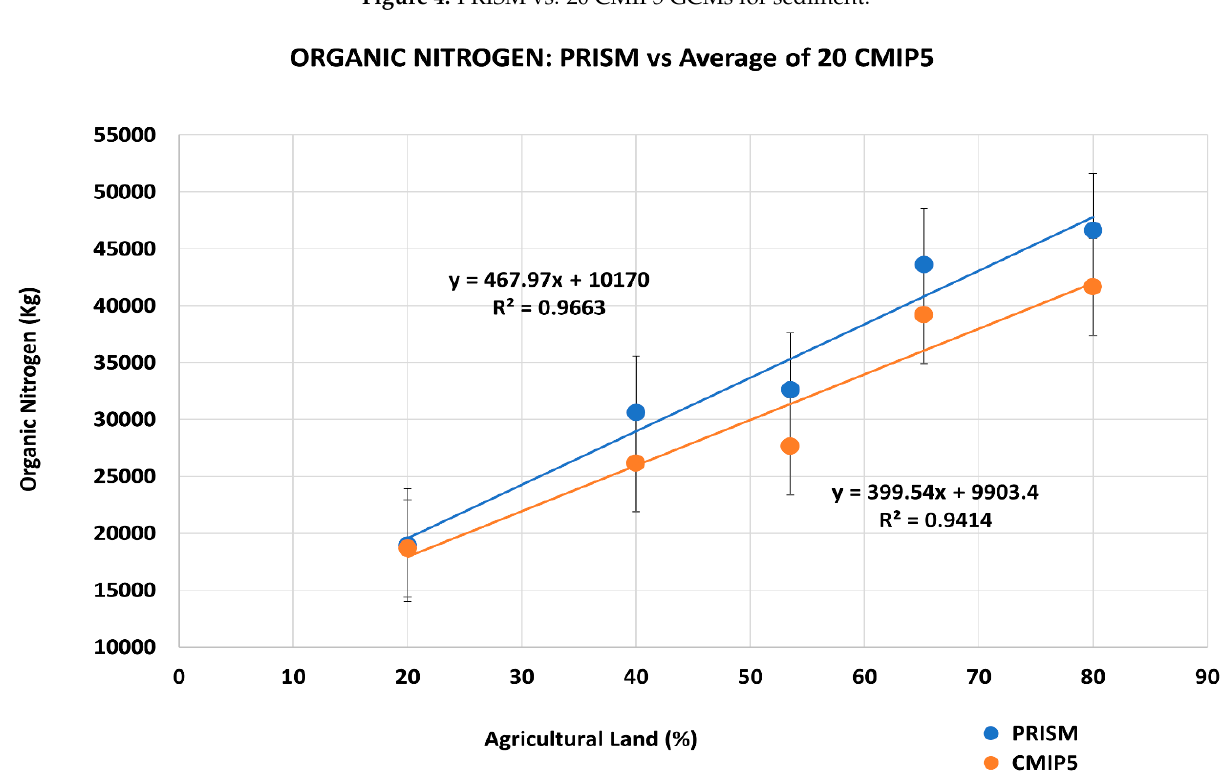
Figure 5. PRISM vs. 20 CMIP5 GCMs for organic nitrogen.